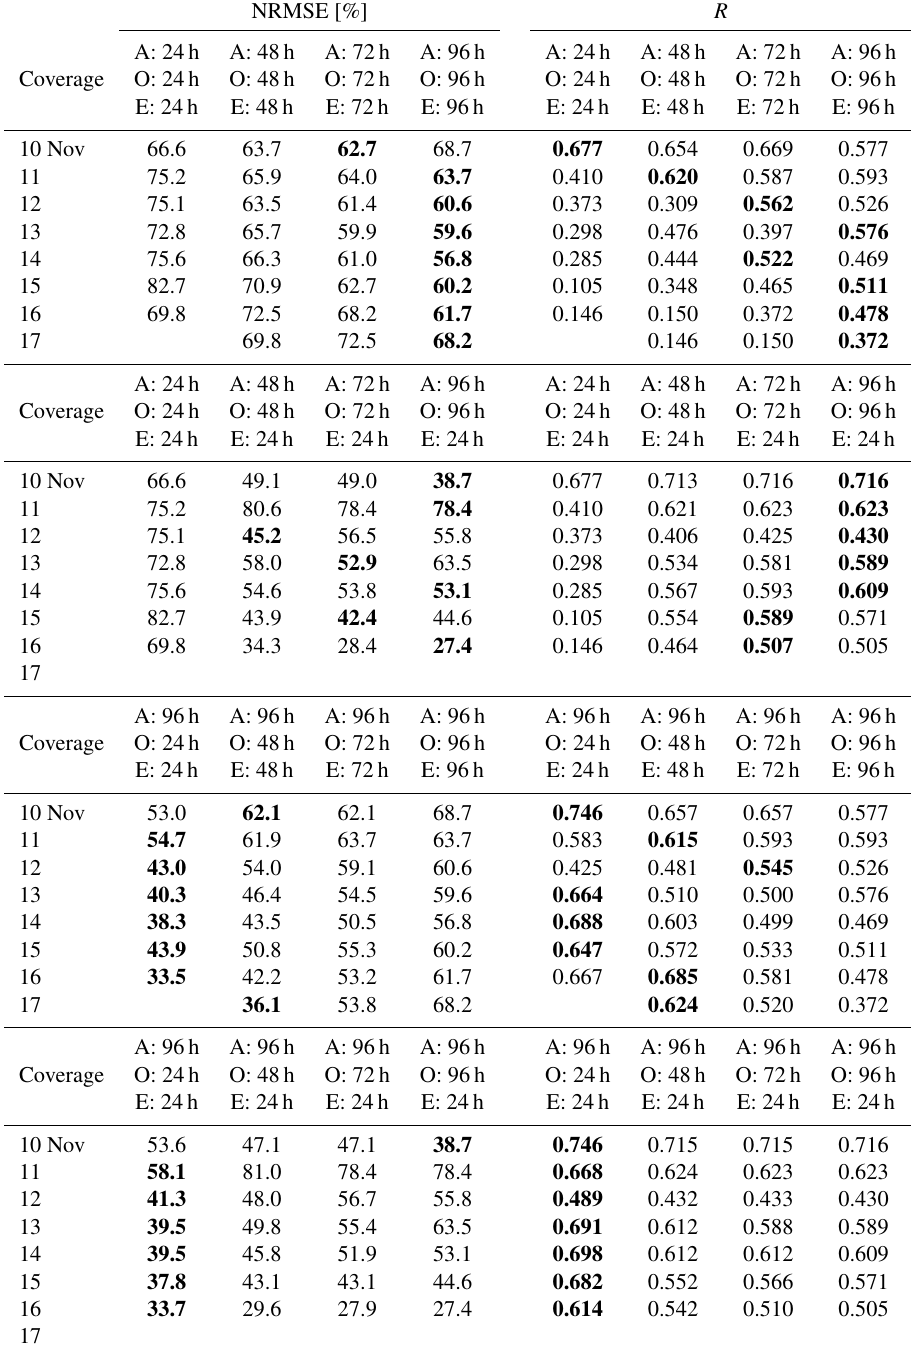
Table 2. Sensitivity test for temporal coverage. Uses of assimilation (A), observation (O), and evaluation (E) time windows (24 to 96h) were tested, and statistics, NRMSE, and R were compared. The best performance is marked in